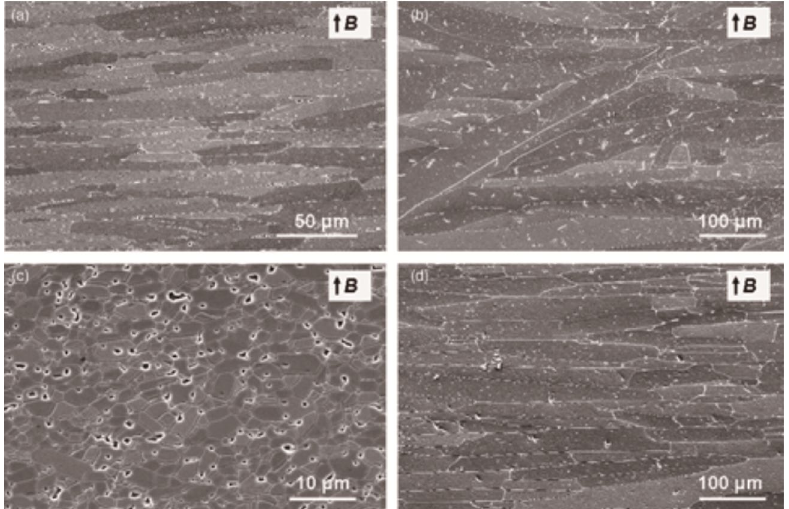
Fig. 13 Surface morphologies of textured α-Al 2 O 3 specimens prepared using raw powders with different grain sizes (μm): (a) 0.37; (b) 0.77; (c) 1.89; (d) 0.37 and 1.89 (7:3). The grain aspect ratios of each specimen are 4.52, 4.30, 1.86, and 5.45, respectively. The Lotgering factors f 110 + 300 of each specimen are 0.80, 0.18, 0.16, and 0.34, respectively. Reproduced with permission from Ref. [84], © The American Ceramic Society